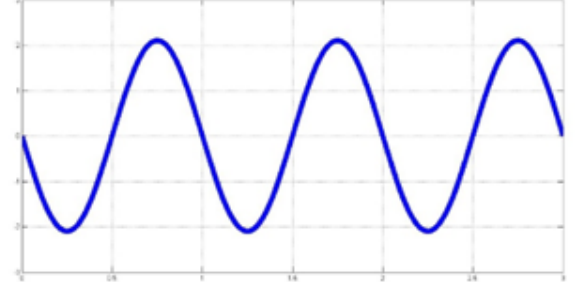
Figure 3. Second sinusoid signal is y